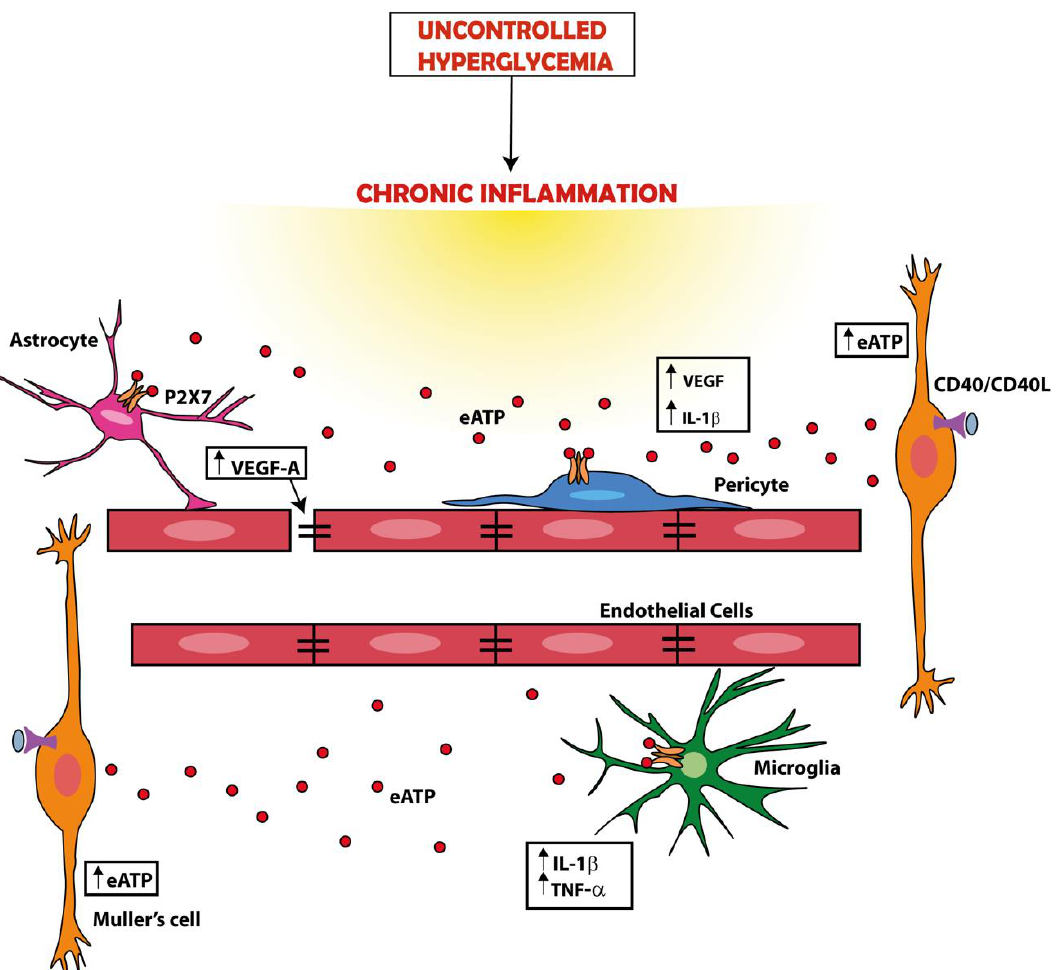
Figure 2. A dysregulation of the ATP-P2X7R axis is a main factor in the pathogenesis of diabetic retinopathy. Hyperglycemia is a cause of chronic inflammation, tissue damage, and cytokine (e.g., IL-1β or TNF-α) release. These events promote ATP release. For example, ATP release can be promoted by ligation of CD40 by CD40L on the plasma membrane of Müller cells or by the activation of the P2X7R itself. The increase in the extracellular ATP (eATP) concentration amplifies inflammation by activating the P2X7R expressed in the retina by several cell types (e.g., Müller cells, astrocytes, microglia, and pericytes), thus causing further release of cytokines and vascular endothelial growth factor (VEGF). VEGF in turn causes a breakdown of the blood–retinal barrier (BRB) promoting the formation of inflammatory exudate and inflammatory cell migration form circulation.